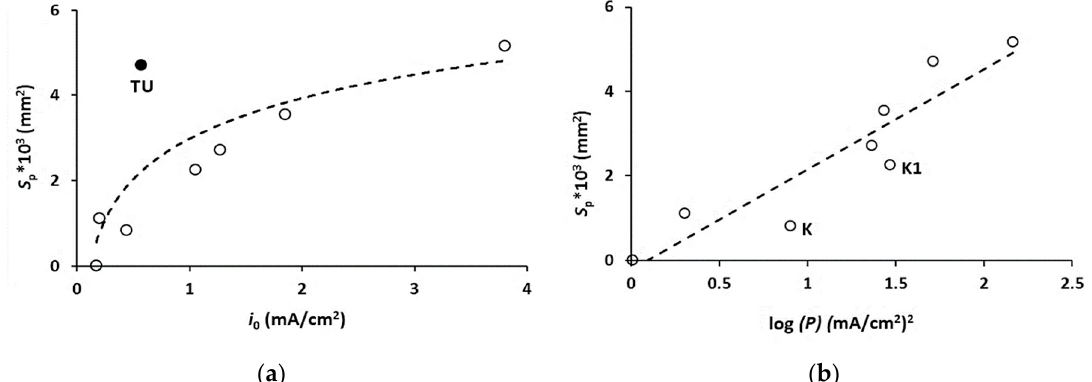
Figure 7. ( a ) Correlations between total area of the pits S p and anodic current ( i 0 ) at the beginning of anodic cycle; ( b ) total area of the pits S p vs. parameter P (Equation (4)) related to the intensity of steel corrosion during SA С P cycles.